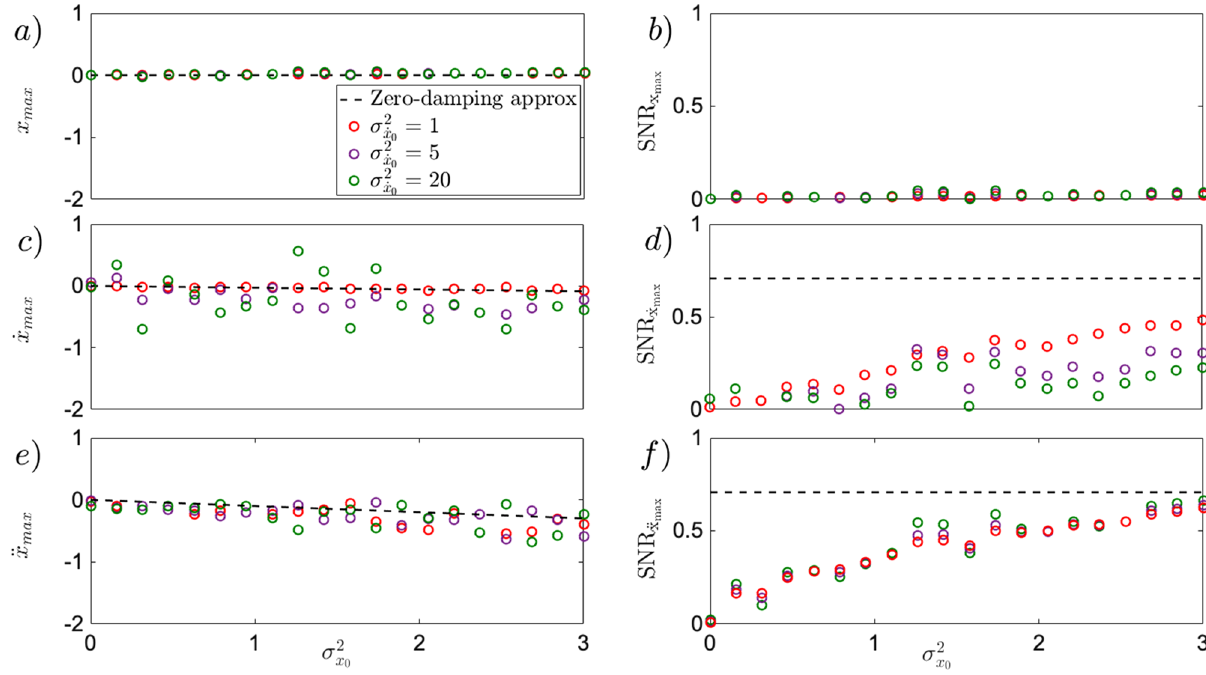
Figure 6. The uncertainty-induced effect in the maxima of distribution for position, instantaneous velocity and acceleration to the uncertainty of the initial velocity state, σ 2 x 0 (a,b) , the evolution of the maximum of ˙ position distribution is not modified by increasing initial uncertainty of the velocity state, σ 2 x 0 , similar to its x ˙ global counterpart (c,d) , the evolution of maximum of velocity distribution is investigated, showing on (cid:31) (cid:30) (c) , almost no sensitivity to small changes in initial velocity uncertainty, but increase requirement of ensemble √ 2 (black dashed line) value but size. Simultaneously , the SNR x on (d) slowly converges to the SNR x = 1 / ˙ ˙ its convergence is reduced with increasing initial velocity uncertainty σ 2 x 0 (e,f) , the local characteristics of ˙ x max (e) , displays little to no sensitivity to increasing initial velocity uncertainty, instantaneous acceleration, ¨ 6 ). The convergence of the SNR while its SNR x requires a high ensemble size to be simulated ( N t = 10 x (f) is ¨ ¨ not modified by increasing initial velocity uncertainty σ 2 x 0 . The black dashed line correspond to the evolution ˙ of maxima of distribution for the zero-damping-limit, shown in Fig.5. Equation (1) has been simulated using κ 6 k B T µ m − 3 kg − 1 , T 300K, x 0 0, Px 0 0, t 0.1ms, dt 2 10 − 6 ms. N t 10 6 trajectories where = = � � = � � = = = × = 5000 samples generated with N =